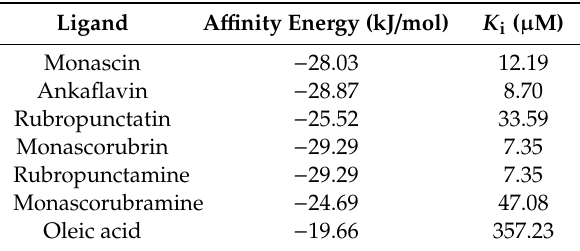
Table 5. Predicted binding energies and computational dissociation constant of Monascus pigments with lipase (PDB: